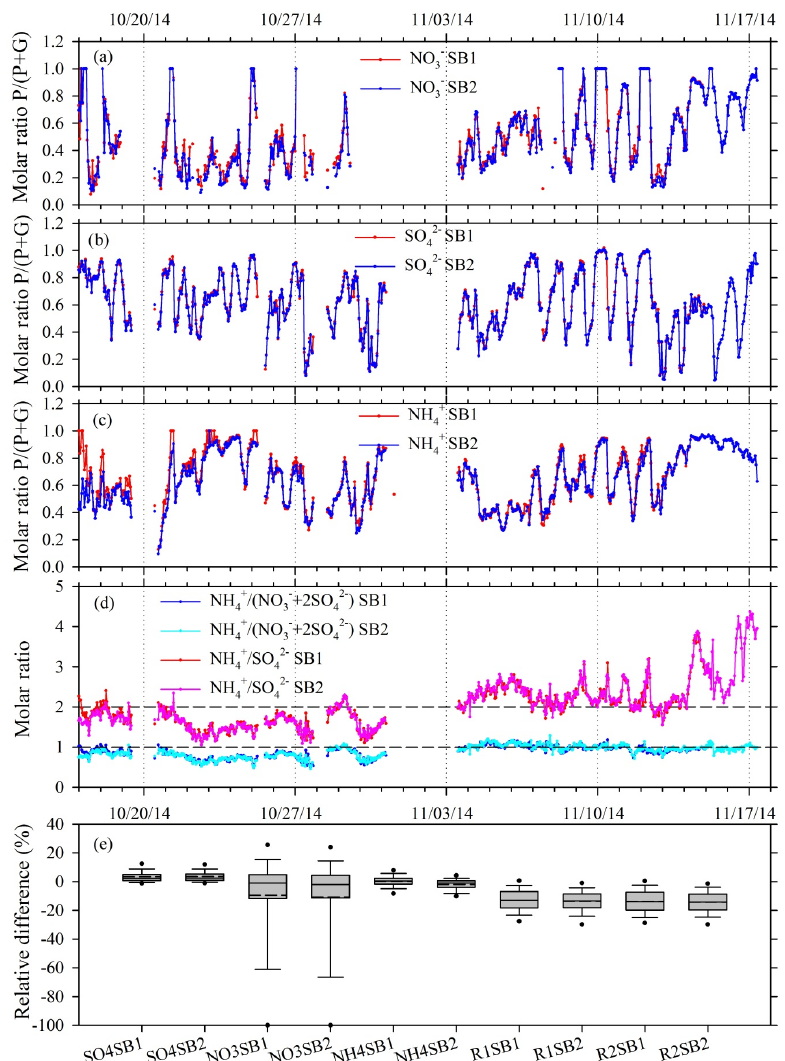
Figure 5. Partitioning molar ratios of (a) NO − , (b) SO 2 − and (c) NH + in particle phase, calculated as particle / (particle + gas). (d) Molar 3 4 4 ratios (R1and R2) of particulate NO − , SO 2 − and NH + to determine particle neutralization state and acidity. (e) Relative difference of parti- 3 4 4 tioning molar ratios of NO − , SO 2 − and NH + in particle phase as well as particle neutralization state indicators R1 and R2 by Chromeleon 3 4 4 and MARGA tool. Negative values indicate a lower ratio calculated by the MARGA tool (i.e., positive bias in concentrations calculated by MARGA tool). Solid and dashed lines inside the boxes represent median and mean, respectively. Top and bottom boxes represent 75th and 25th percentiles. Whiskers represent 90th and 10th percentiles. Dots represent 95th and 5th percentiles. SB1 and SB2 indicate collocated MARGA sample boxes 1 and 2,